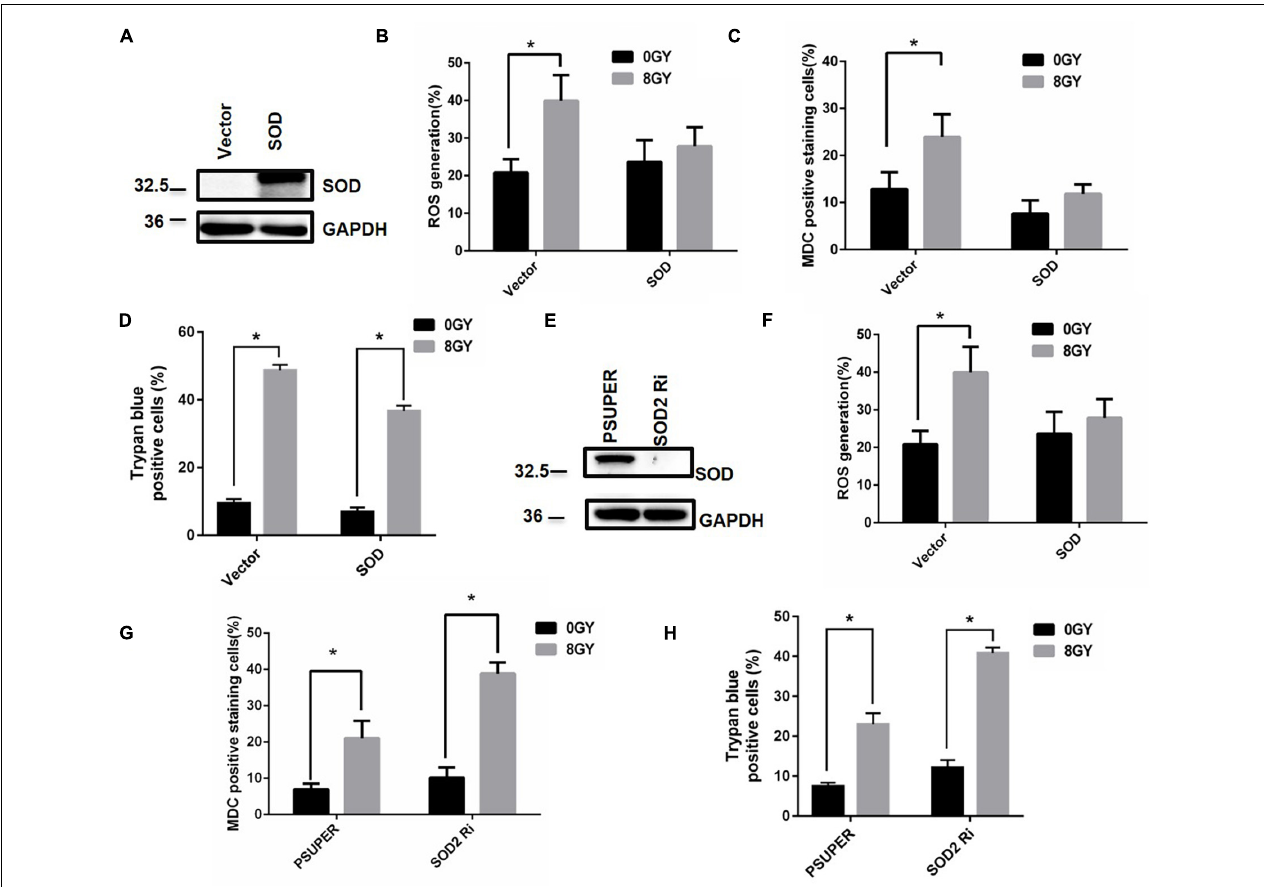
FIGURE 7 | Superoxide dismutase (SOD2) decreased autophagy and cell death after radiation treatment. Cells were transfected with control vector (Vector) and SOD2 overexpression plasmid (SOD) for 24 h, the SOD2 expression was tested by Western blot (A) . Intracellular ROS (B) autophagic rate (C) and the amount of cell death (D) were determined at 48 h after radiation treatment. Cells were transfected with control vector (pSUPER) and siRNA against SOD2 (SOD2 Ri) for 48 h, the SOD2 expression was tested by Western blot (E) . Intracellular ROS (F) , autophagic rate (G) , and the amount of cell death (H) were determined at 48 h after radiation treatment. These results were representative of three independent experiments and expressed as means ± SD. P -values were calculated using repeated measure ANOVA with P < 0.05 being considered as statistical significance, * P <